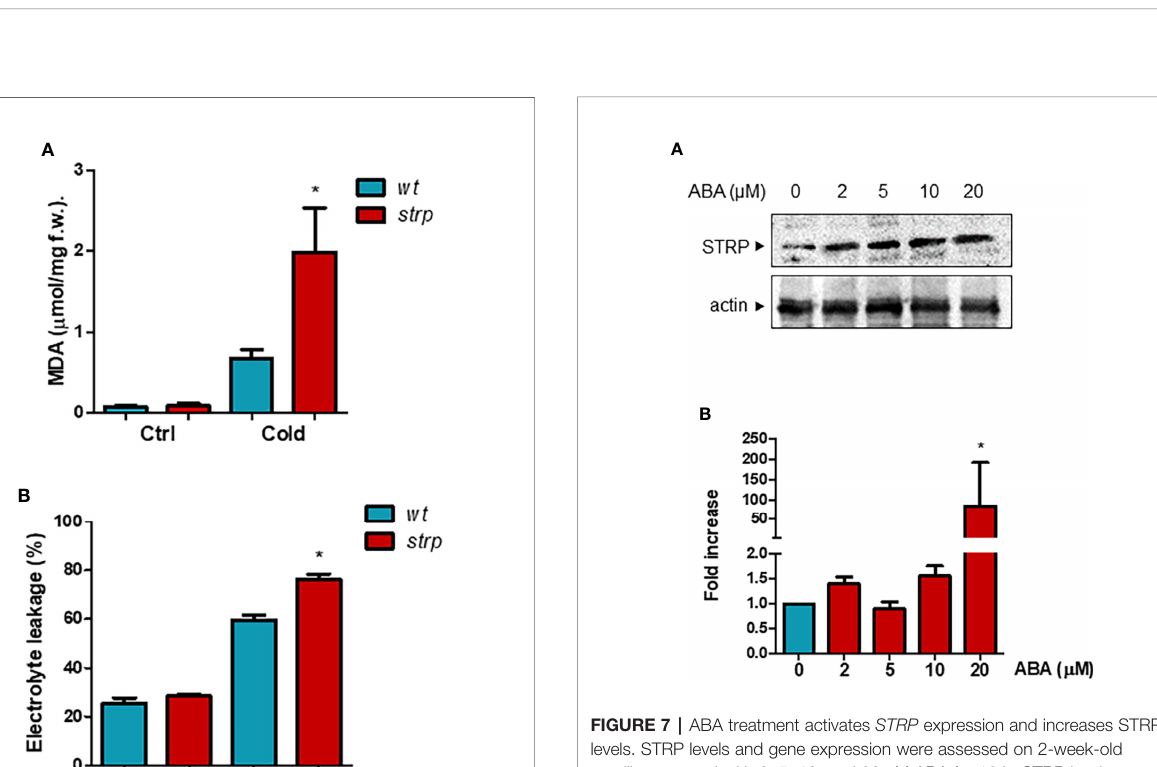
FIGURE 5 | Cold stress affects wild type and strp plant growth. Rosette leaf area was determined on plants grown in universal soil for three weeks and then exposed to low temperature, during the night, for additional 5 days. Rosette area was determined with EasyLeaf area software. Panel A : ctrl; Panel B : cold treated; Panel C : percent ratio of growth inhibition between strp and wild type plants. Error bars are S.E.M. of four independent experiments. *P < 0.01, by Student ’ s t-test.